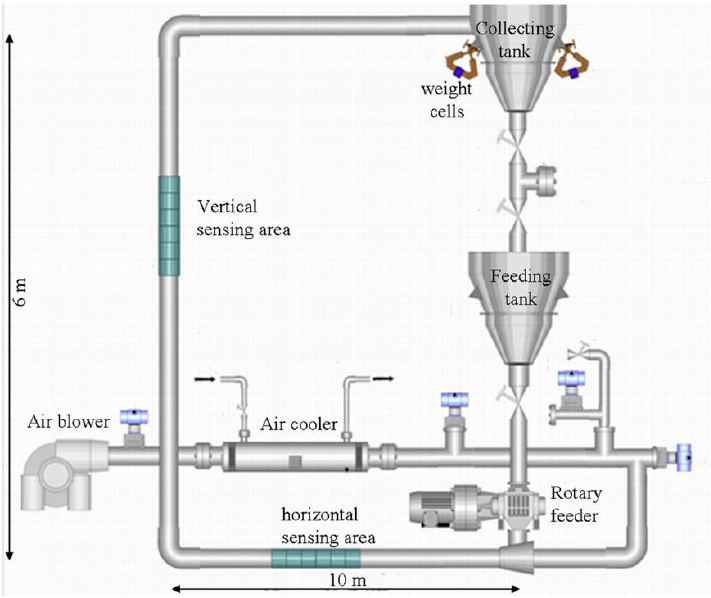
/ gas pneumatic flow